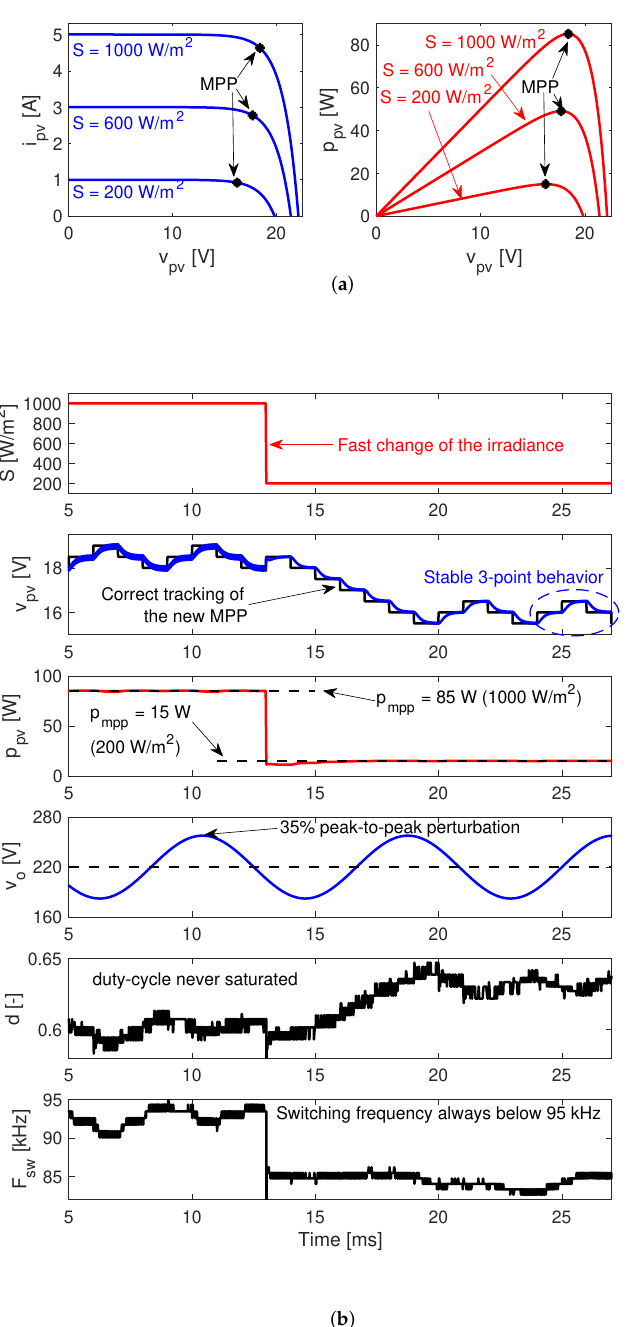
Figure 10. SMC and MPPT performance for variations on both the irradiance and output